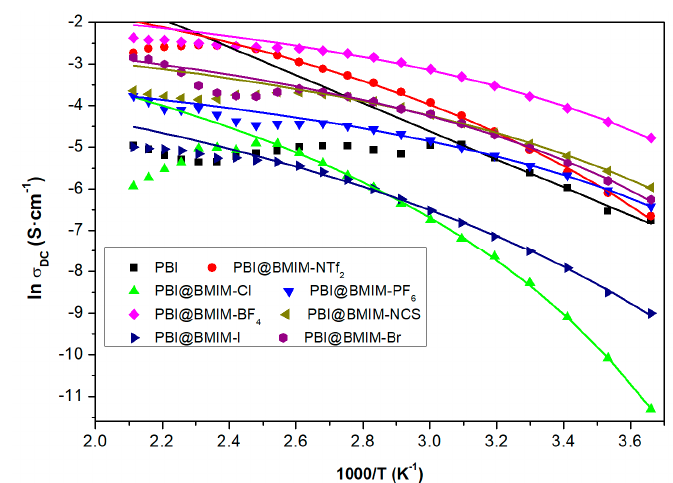
Figure 7. Variation of the ln σ dc as a function of the reciprocal of the temperature for phosphoric acid doped PBI composite membranes containing 5 wt.% of 1-butyl-3-methylimidazolium (BMIM)-X (X: [NTf 2 ] − , [Cl] − , [BF 4 ] − , [I] − , [PF 6 ] − , [NCS] − and [Br] − ). For comparison, the conductivity dependence with temperature for PBI pristine membrane doped with phosphoric acid is also given.